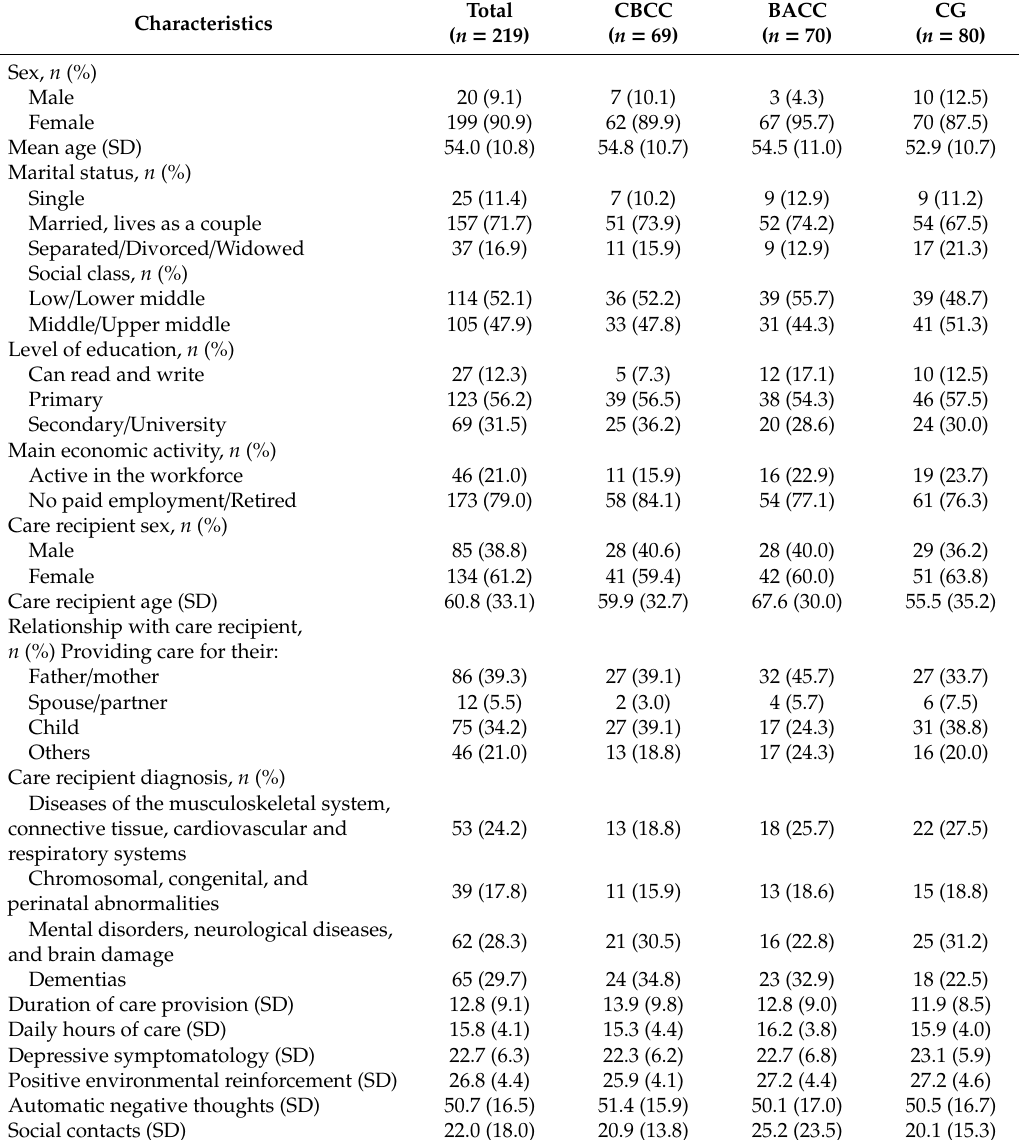
Table 2. Sociodemographics, clinical characteristics, and care situation of the study participants.